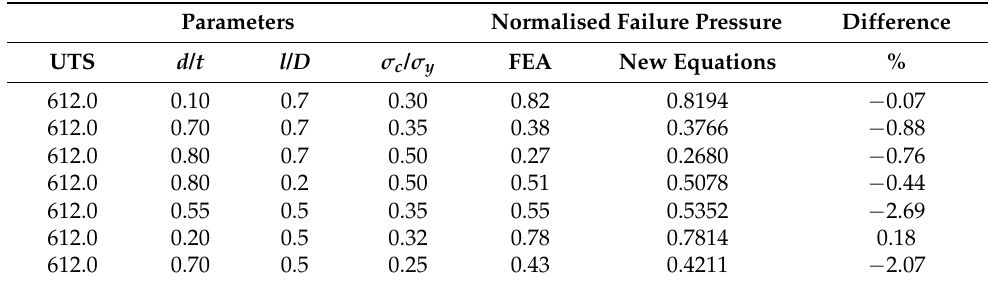
Table 7. Normalised failure pressure prediction using FEA and prediction based on the assessment equations of an unseen